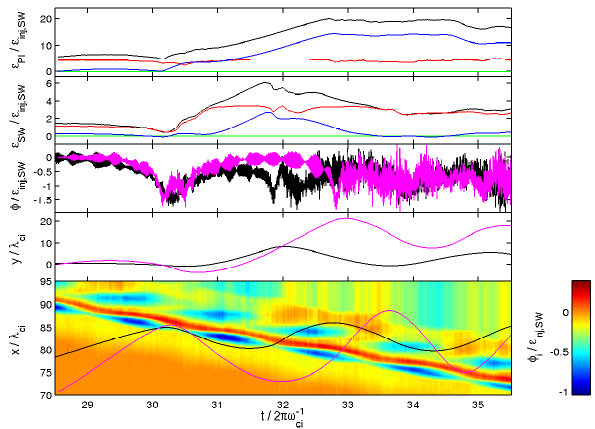
Fig. 8. Top panel (panel 1) shows the energy of a pickup proton, cal- culated from R F · v dt and its components ( x − red, y − blue, z − green, total − black), panel 2 the energy of a solar wind proton. Panel 3 shows R E x dx at the position of both protons (solar wind − black, pickup − purple), panel 4 the y -positions, calculated from y = R v y dt , and panel 5 the x -positions overlayed onto the shock potential on ion scales (plotted as R E x,i dx